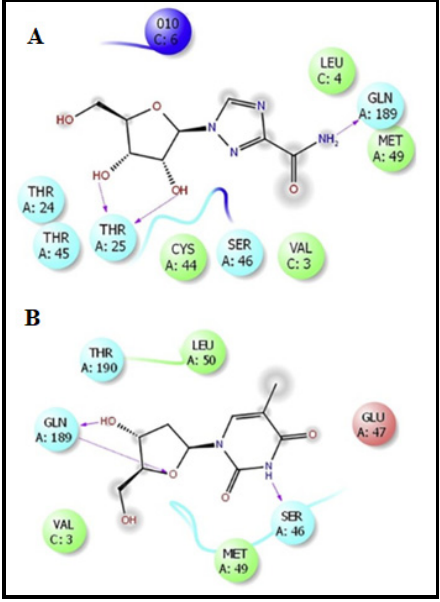
Figure 9. Mpro ligand interactions with ( A ) ribavirin and ( B ) telbivudine [63]. Copyright © 2021 Elsevier Inc.